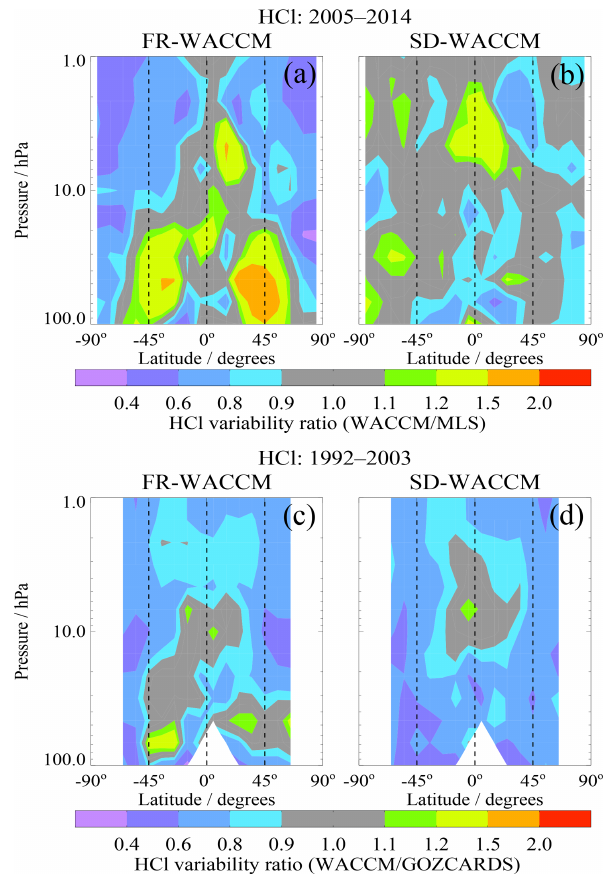
Figure 17. Same as Fig. 14 but for ratios (model/data) of HCl strato- spheric